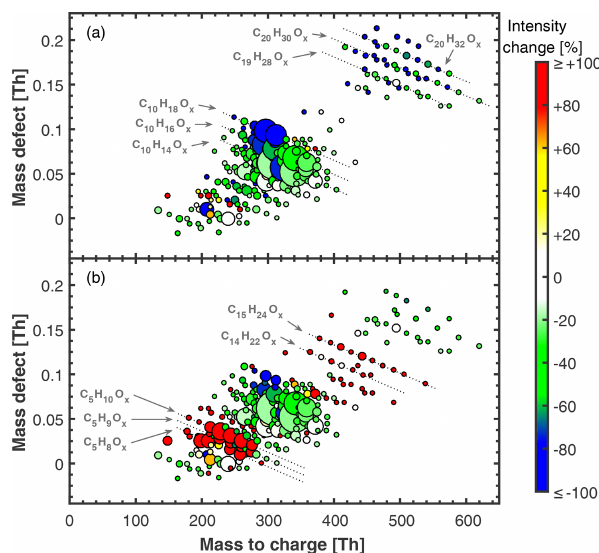
Figure 1. Mass defect plots of neutral HOM molecules measured with nitrate CI-API-TOF without isoprene (a) and with isoprene added (b) at + 25 ◦ C. α -Pinene levels were 771 and 1326pptv, re- spectively. Ozone levels were 49 and 39ppbv, respectively. Isoprene was 4.9ppbv in (b) . Relative humidity was 38% in (a) and (b) . The area of the marker points is linearly scaled with the intensity of the HOM signals. Colour code shows the relative intensity change for each HOM peak due to isoprene addition, i.e. the percentage inten- sity change between (a) and (b) . The colour for each peak is thus the same in (a) and (b) . HOM intensity in (a) was scaled up linearly by 38% to match [ α -pinene] ·[ O 3 ] levels present in (b) to calculate the intensity